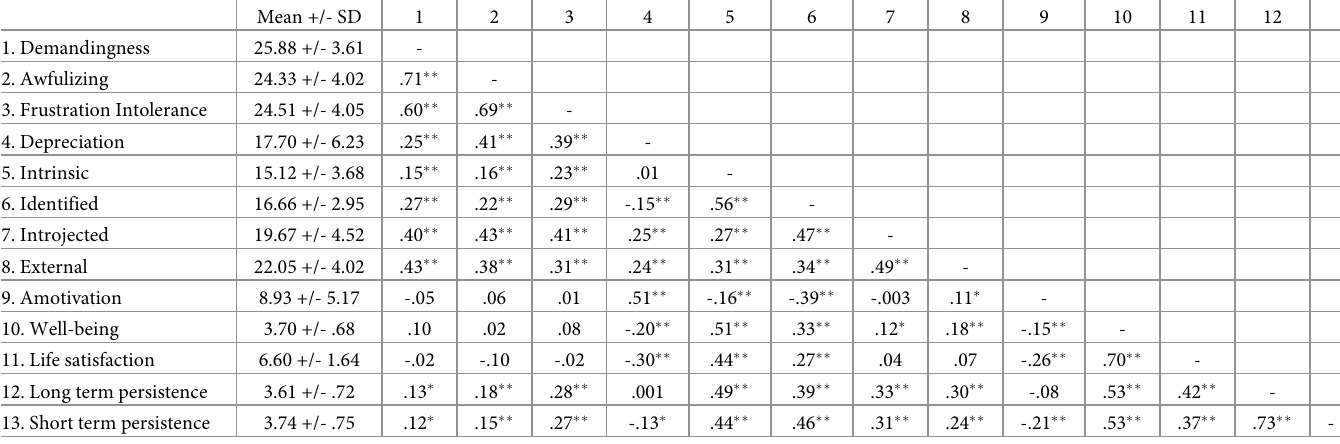
Table 1. Scale reliabilities, descriptive statistics and inter-correlations Study